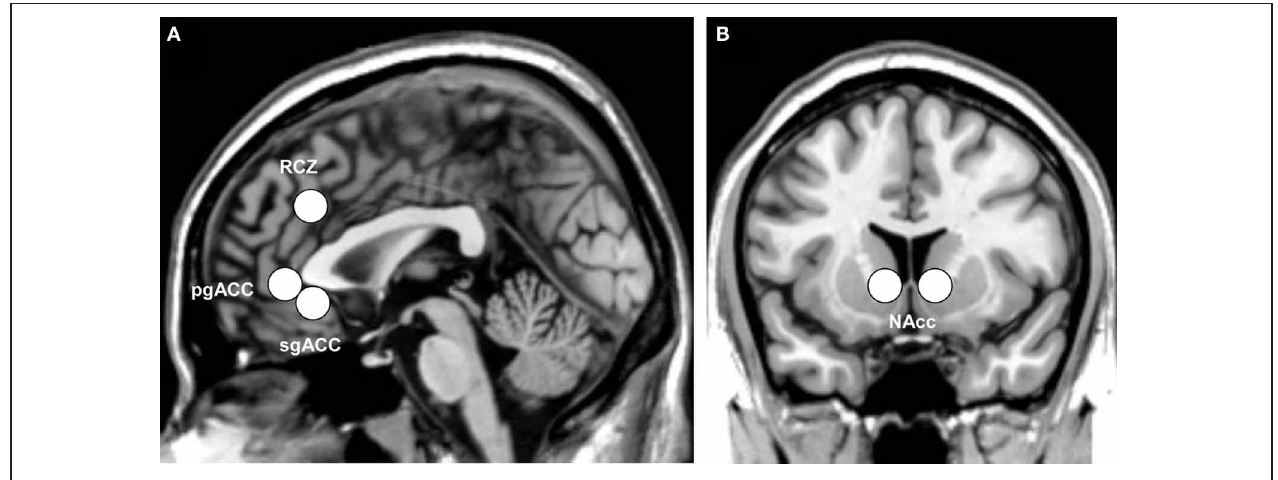
FIGURE 2 | Indication of the anatomical location of (A) the three subdivisions of the anterior cingulate cortex: the rostral cingulate zone (RCZ), pregenual anterior cingulate (pgACC), and